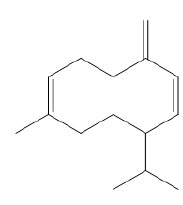
Figure 4. Phytochemicals from Veronica linariifolia essential oil.